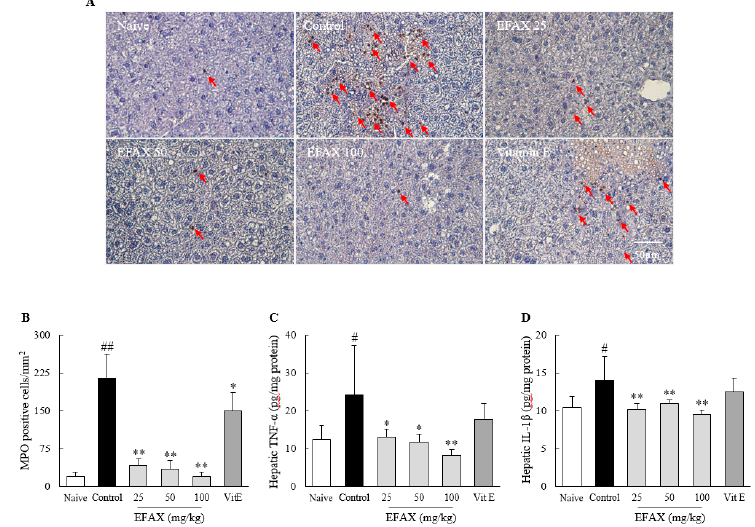
Figure 5. Effects on myeloperoxidase (MPO) staining and inflammatory cytokines. Mice ( n = 8 in each group) were fed a 60% high-fat diet for 8 weeks, excluding the naive group (normal chow diet). From the 3rd week of high-fat diet feeding, distilled water (control), EFAX (25 mg/kg, 50 mg/kg, 100 mg/kg), and vitamin E (100 mg/kg) were administered by gavage daily for the last 6 weeks. MPO staining ( A ) of liver sections was performed, and representative photographs (400× magnification) were semi- quantified ( B ). Hepatic levels of tumor necrosis factor (TNF)- α ( C ) and interleukin (IL)-1 β ( D ) were evaluated. # p < 0.05, ## p < 0.01 compared with the naive group; ∗ p < 0.05, ∗∗ p < 0.01 compared with the control group.